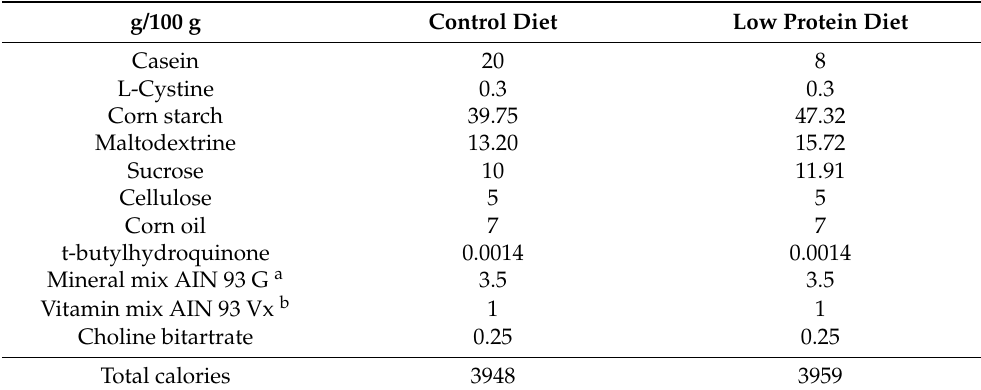
Table 1. Composition of control and low-protein diets.